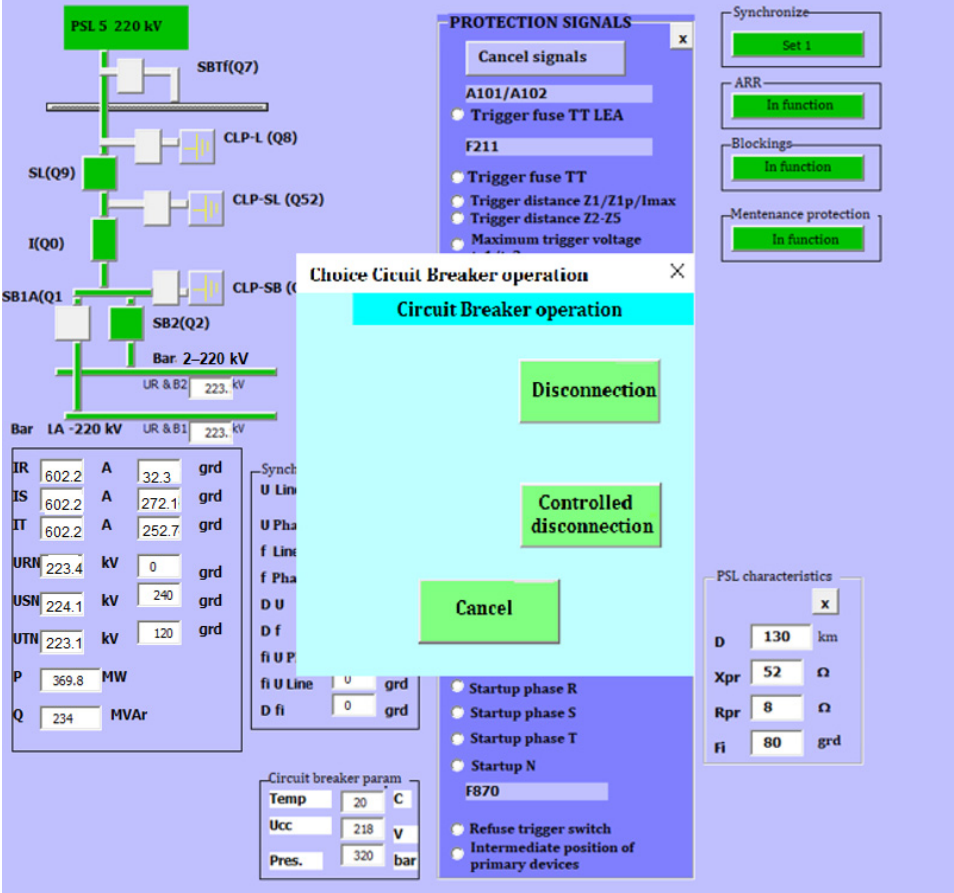
Figure 25. The control screen of the circuit breaker’s disconnection.